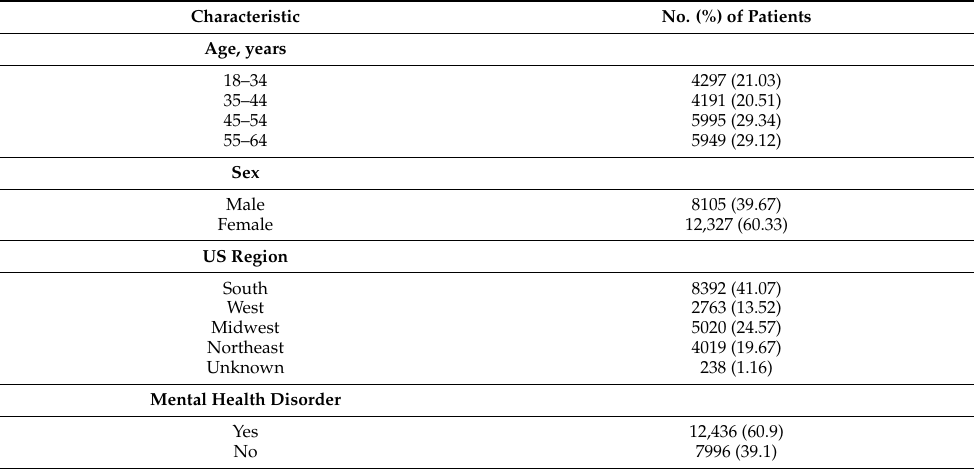
Table 1. Baseline characteristics of patients with low-grade